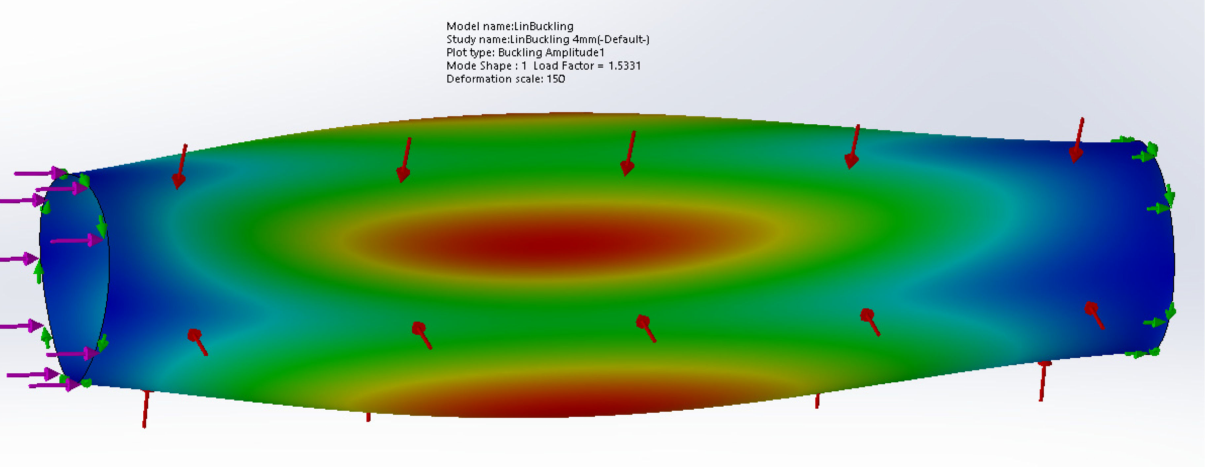
Figure 7. Simple cylinder–Linear buckling FEA: analysis